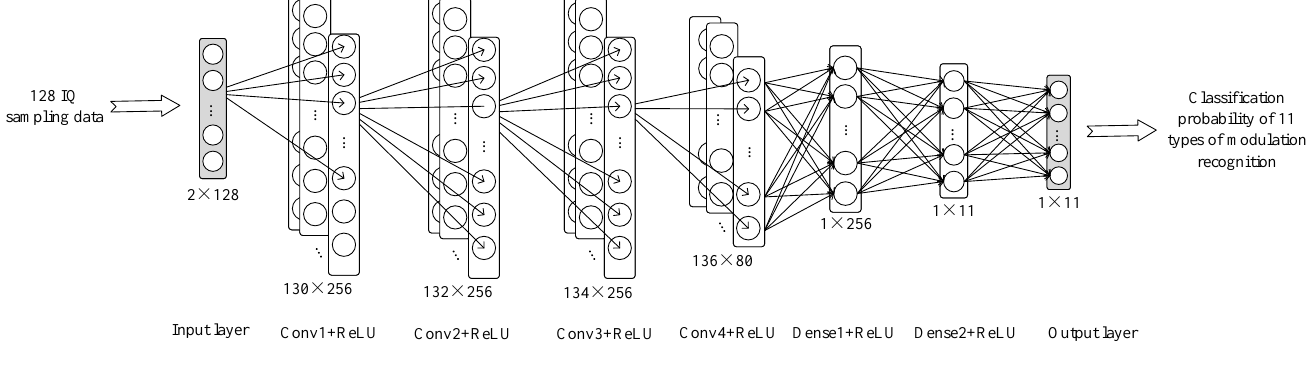
Figure 8. Modulation recognition model based on CNN. Table 11. Detailed structure of the